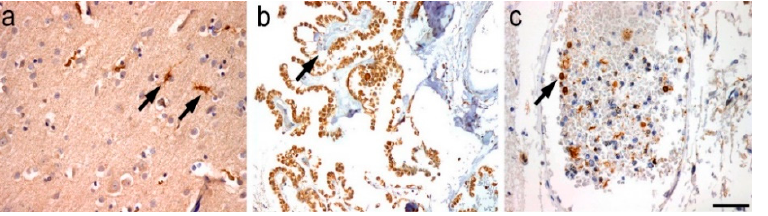
Figure 2. ( a ) SOAT1 expression in microglial cells of normal brain (frontal cortex), ( b ) in cuboidal cells of the choroid plexus, and ( c ) in circulating monocytes (scale bar 200 µm).